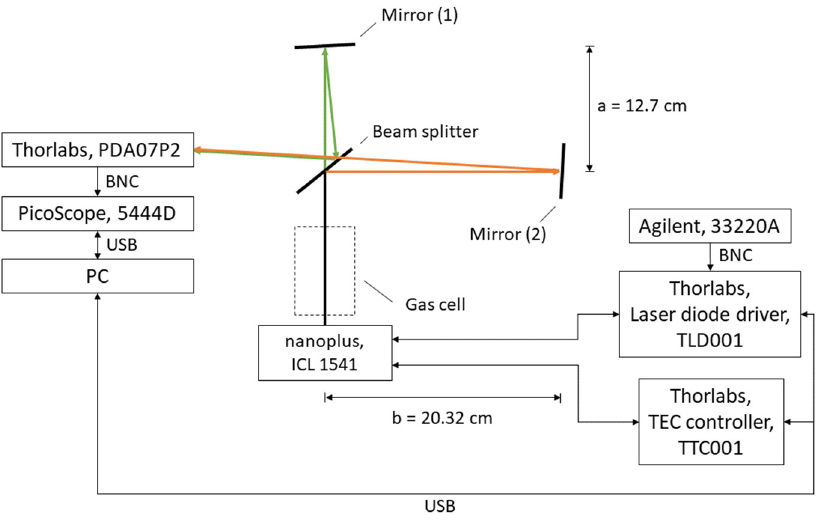
Figure 1. Experimental setup based on a Michelson interferometer.